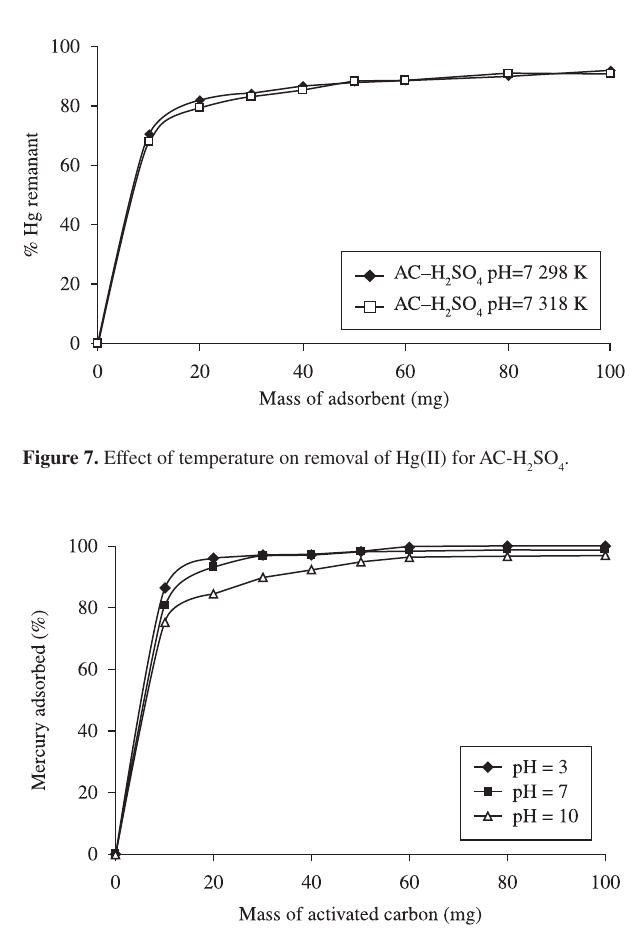
Figure 8. Effect of pH on removal of Hg(II) for AC-H